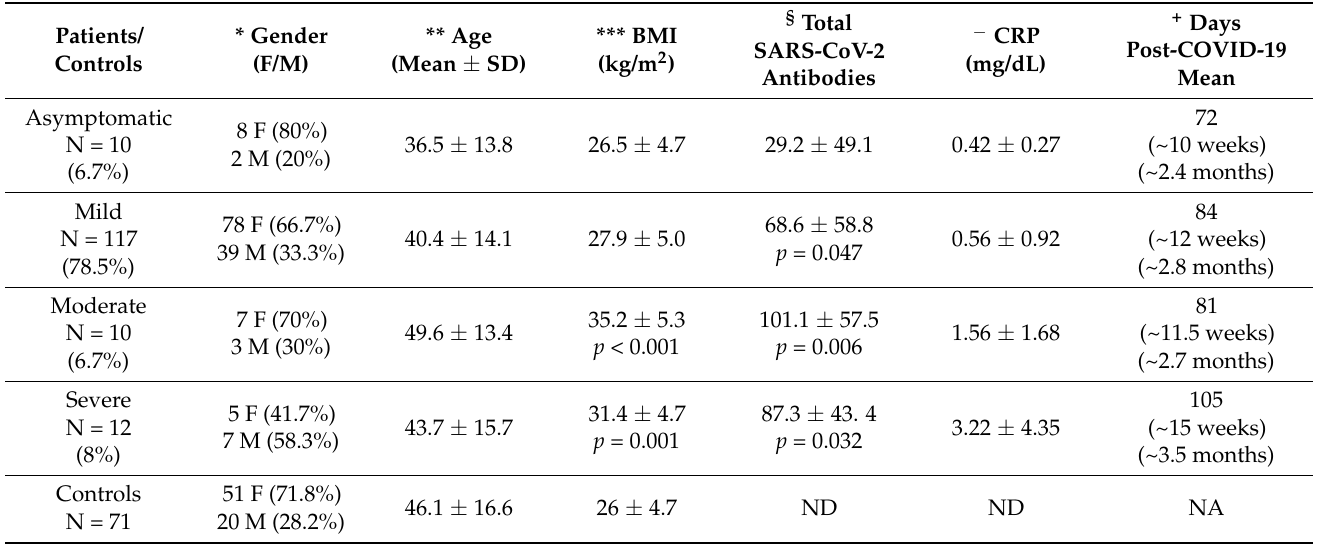
Table 1. Demographic, anthropometric, and clinical data from post-COVID-19 patients based on disease severity classification during the acute phase, and demographic and anthropometric data from control